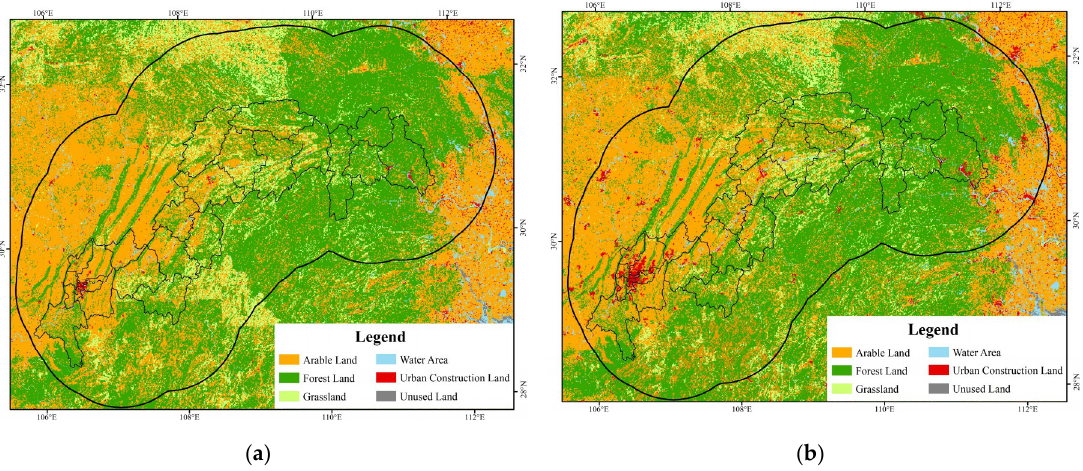
Figure 3. Land use/land cover changes in the study area: ( a ) land use/land cover in the study area in Figure 3. Land use / land cover changes in the study area: ( a ) land use / land cover in the study area in 2000; and ( b ) land use/land cover in the study area in 2018. 2000; and ( b ) land use / land cover in the study area in